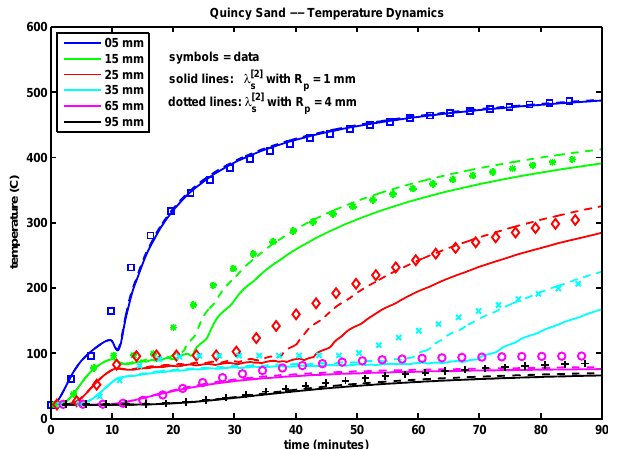
Figure 1. Comparison of measured (symbols) and modeled (lines) soil temperatures during the Quincy Sand heating experiment. Nei- ther simulation includes a dynamic residual soil moisture term, θ r . The solid lines are for a model simulation with R p = 1mm; the dot- ted lines corresponds to a simulation for R p = 4mm. Note as R p increases the infrared portion of the soil thermal conductivity, λ also increases, in accordance with Eq. (14). To compare with the equilibrium model, see Fig. 2 of Massman (2012).